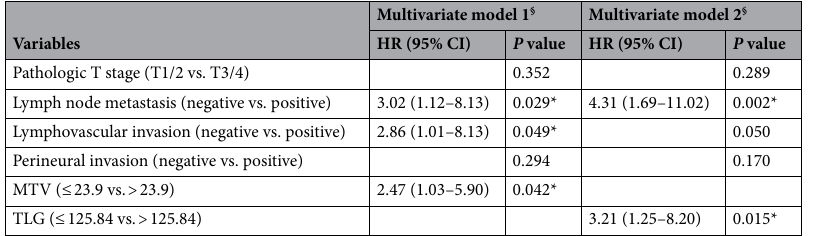
Table 3. Multivariate analysis of prognostic factors for disease-free survival. CI confidence interval, HR hazard ratio, MTV metabolic tumour volume, TLG total lesion glycolysis. § MTV (model 1) and TLG (model 2) were separately assessed in a stepwise multivariate Cox proportional hazards model. *Statistically